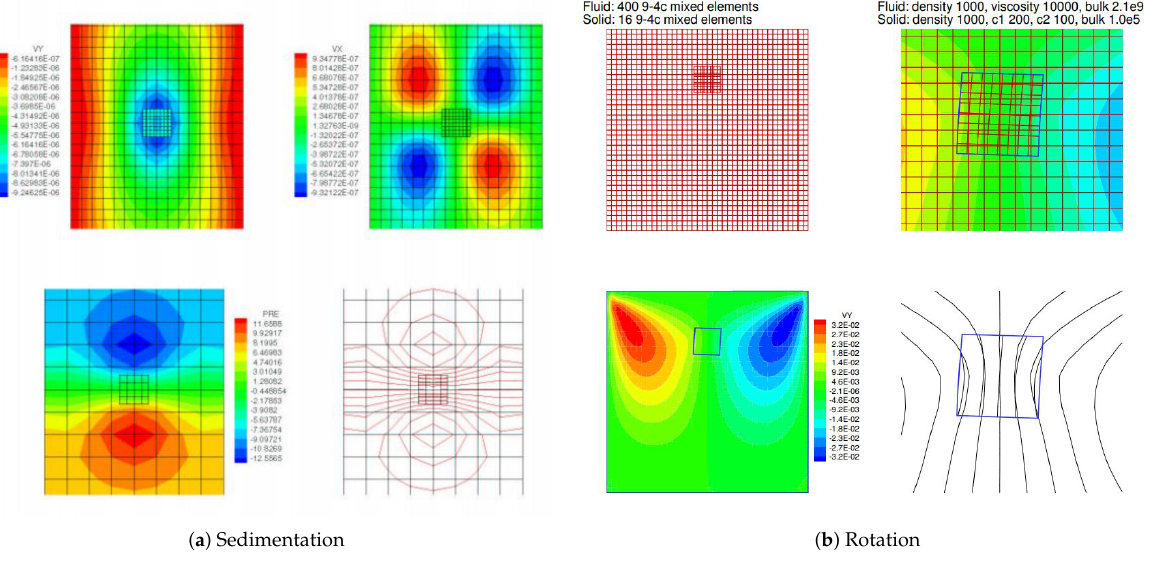
Figure 13. Fully converged velocity and pressure contours and bandplots.